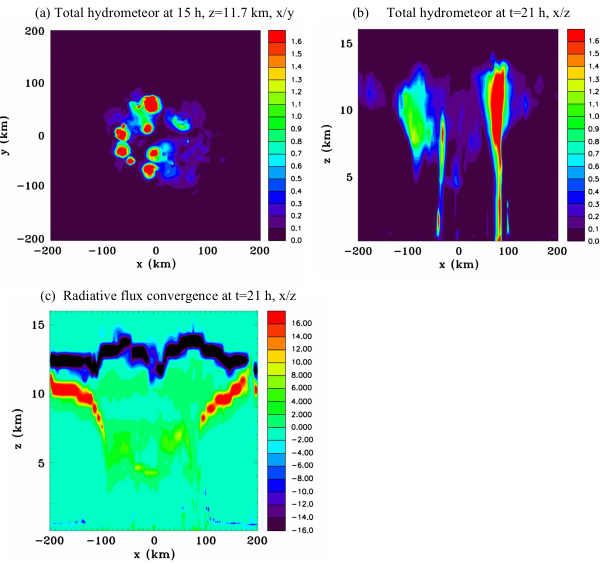
Figure 20. Experiment 13: full physics with radiation in the whole domain. (a) Horizontal section of total hydrometeor mixing ratio at z = 11 . 7km. t = 15h (gkg − 1 ), (b) vertical section of total hy- drometeor mixing ratio at t = 21h (gkg − 1 ), and (c) vertical section of radiative flux convergence at t = 21h ( × 10 − 5 Ks − 1 ).